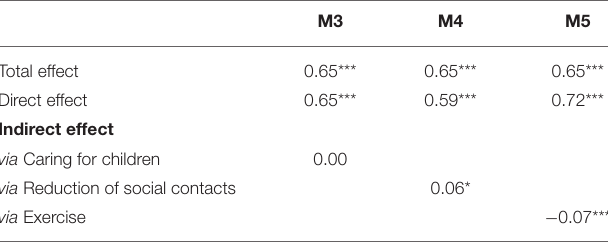
TABLE 4 | KHB models based on linear